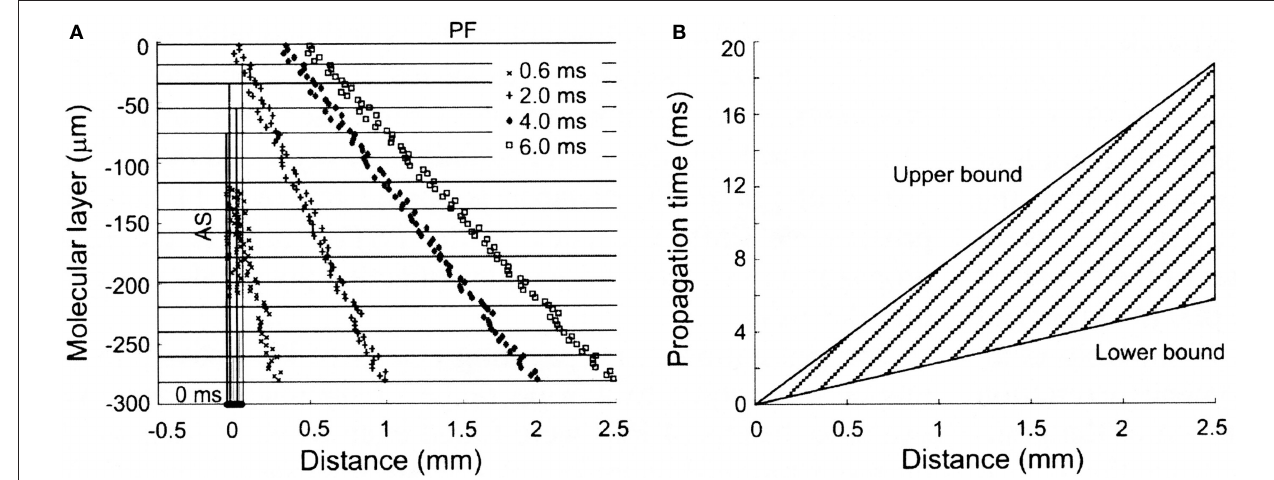
of propagation times for action potentials converging at different distances from the site of granule cell activation. The upper and lower bounds are calculated using the slowest (0.15 m/s) and fastest (0.50 m/s) published propagation velocities for parallel fiber action potentials. Reproduced with permission from Santamaria et al.,